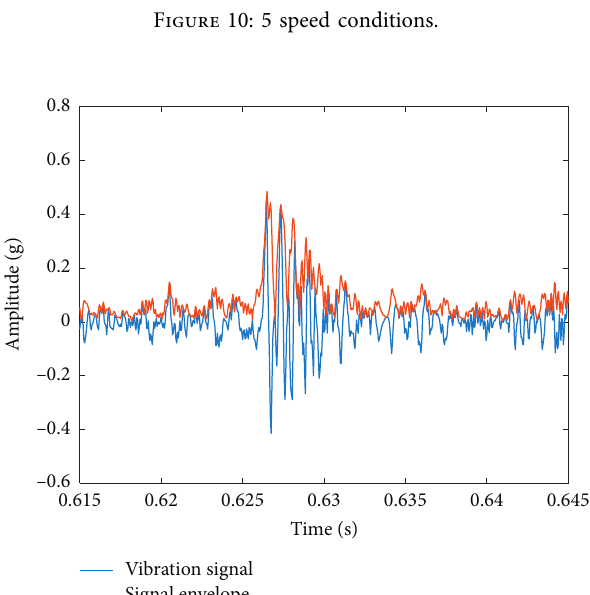
Figure 11: Original monopulse with missing detail